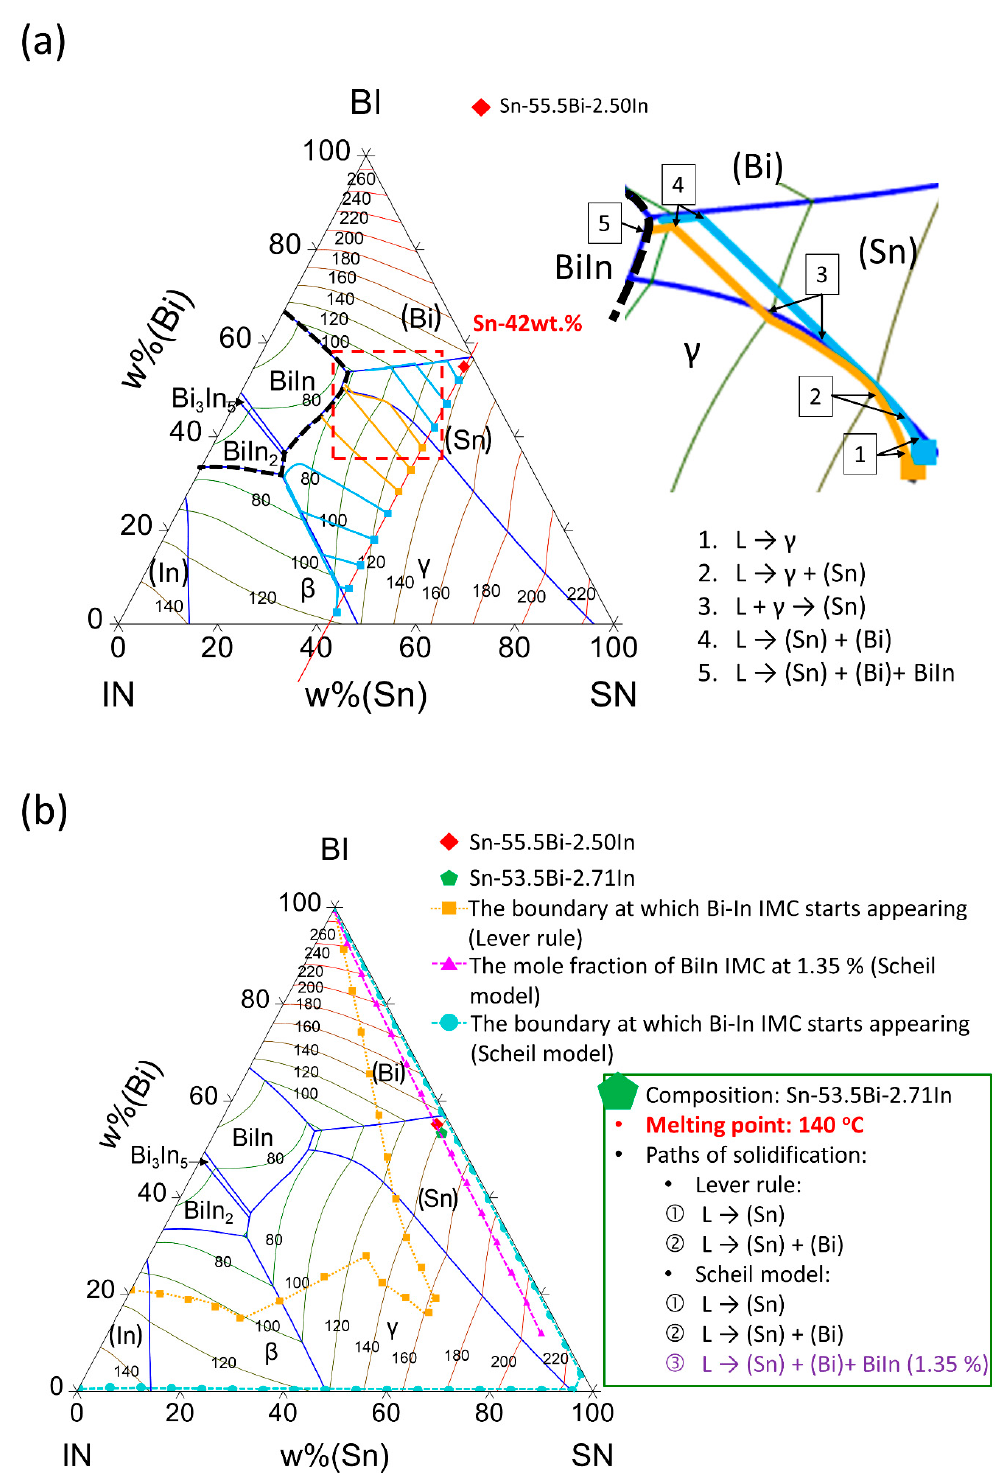
Figure 2. ( a ) The calculated liquidus projection of the Sn-Bi-In ternary system with liquidus isotherms every 20 ◦ C. ( b ) The boundary at which BiIn intermetallic compound (IMC) starts appearing based on the lever rule and the Scheil model, and the 1.35 % mole fraction of BiIn IMC based on the Scheil